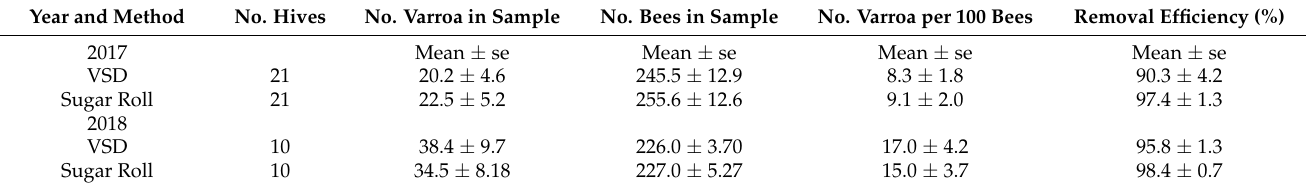
Table 5. Summary statistics (mean ± standard err (se)) for the comparison between the Varroa Shaker Device (VSD) and the sugar roll methods in their efficiency to remove mites from samples of honey bees for evaluations run in both 2017 and